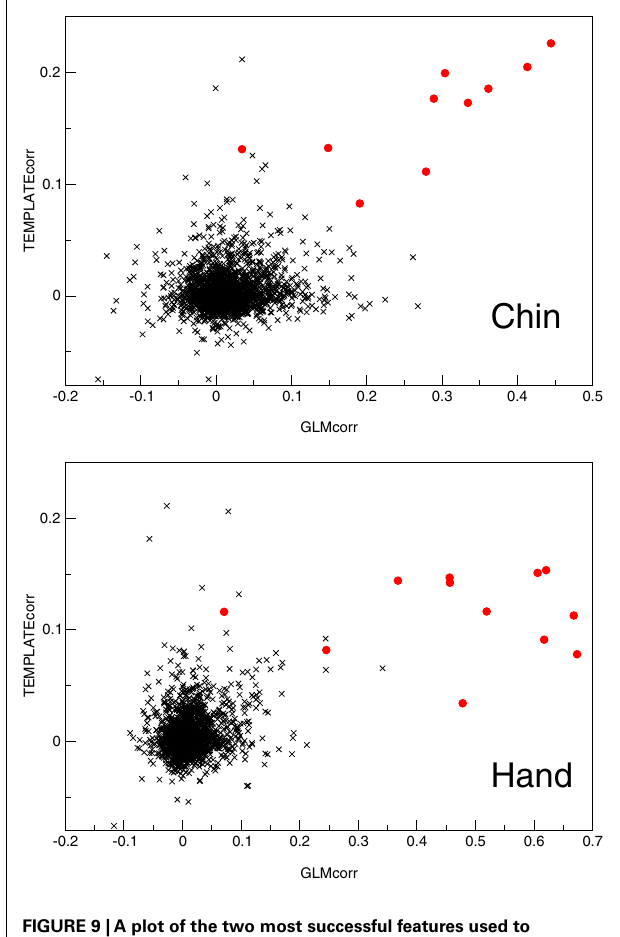
FIGURE 9 |A plot of the two most successful features used to automatically identify primary motor activation components (red circles) amongst other components (black crosses) in the Chin and Hand groups